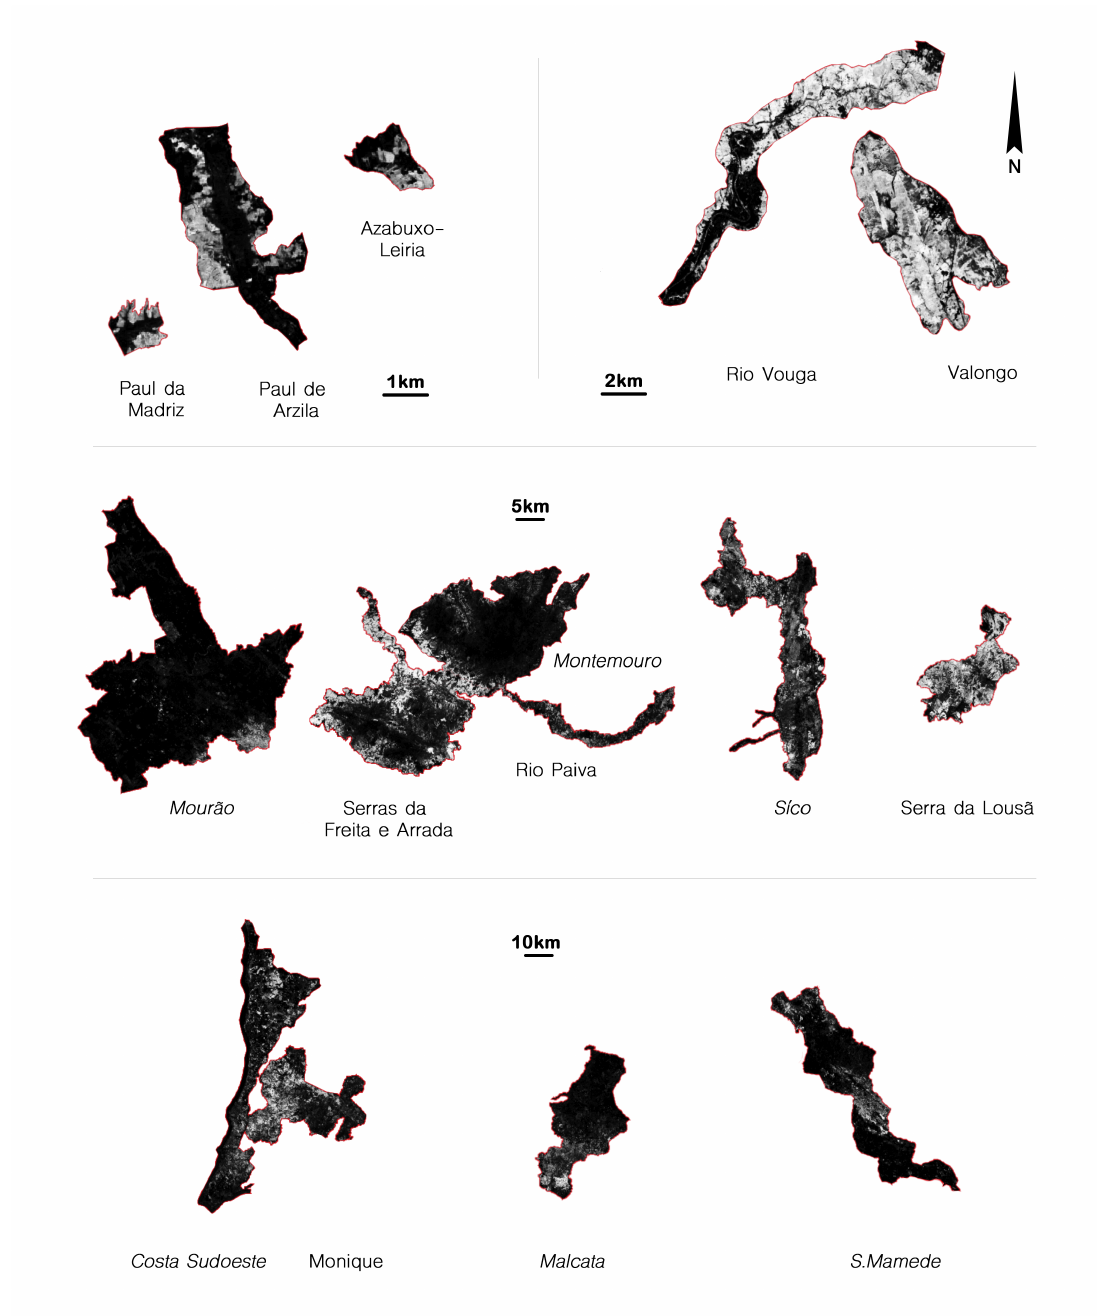
Figure 8. Map of Natura 2000 areas that are in large parts covered with Eucalyptus . The determined mean probability of a pixel being covered with Eucalyptus is shown for the study area in the range from 0 (black) to 1 (white) for the year 2018. Names of affected sites in italic font. Strongly affected sites in regular